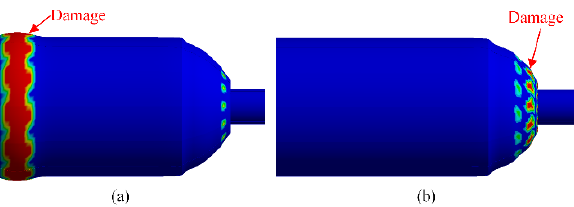
Figure 11. Comparison of numerical results of two burst modes: ( a ) safe mode, ( b ) unsafe mode.